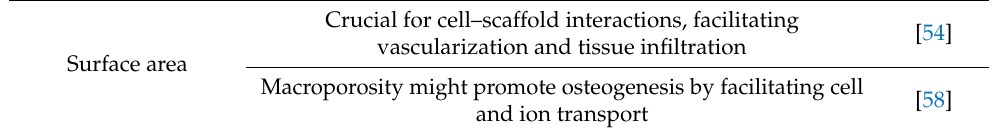
Table 1. Scaffold properties for design considerations.